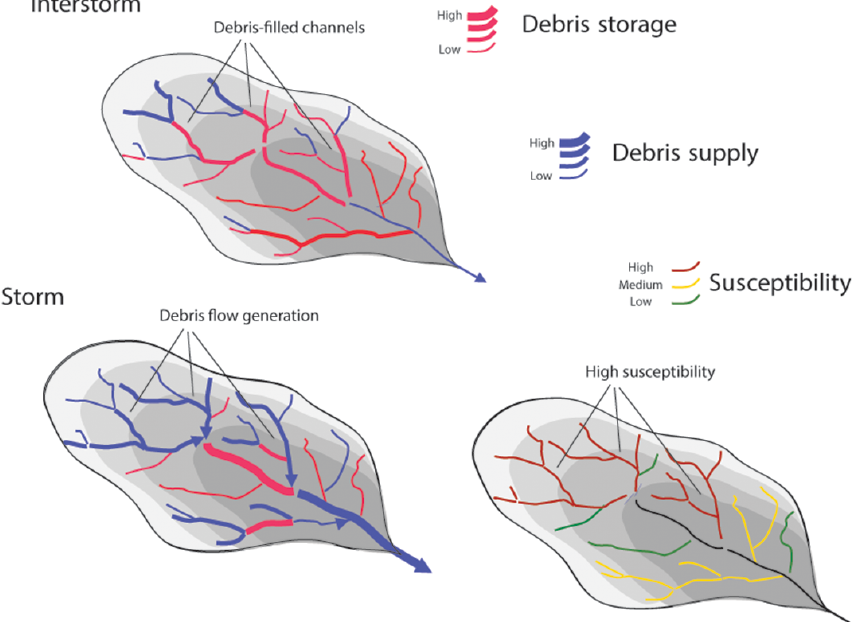
Figure 11. Conceptual model of the relation between hydraulic capacity during the intense long-lived rainfalls of an extraordinary storm and debris storage over a previous time span that explains different levels of debris flow susceptibility depending on catchment